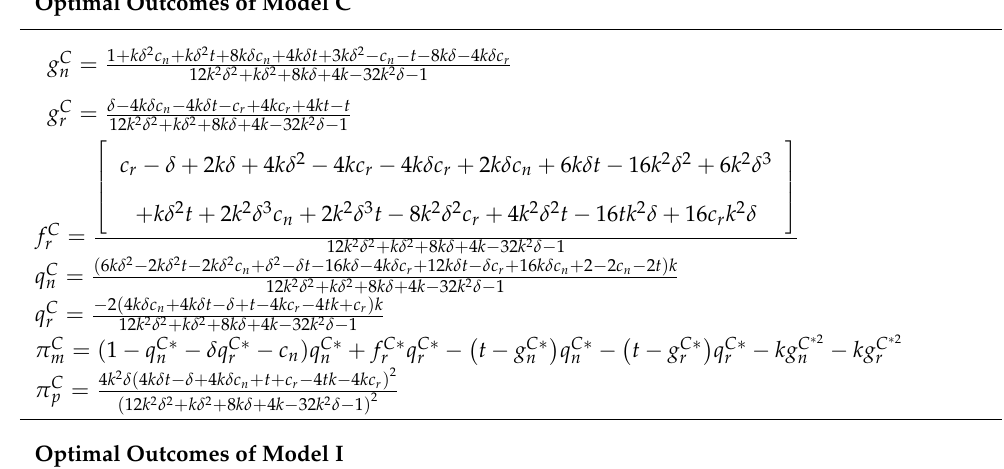
Table 3. Equilibrium decisions and profits. Optimal Outcomes of Model